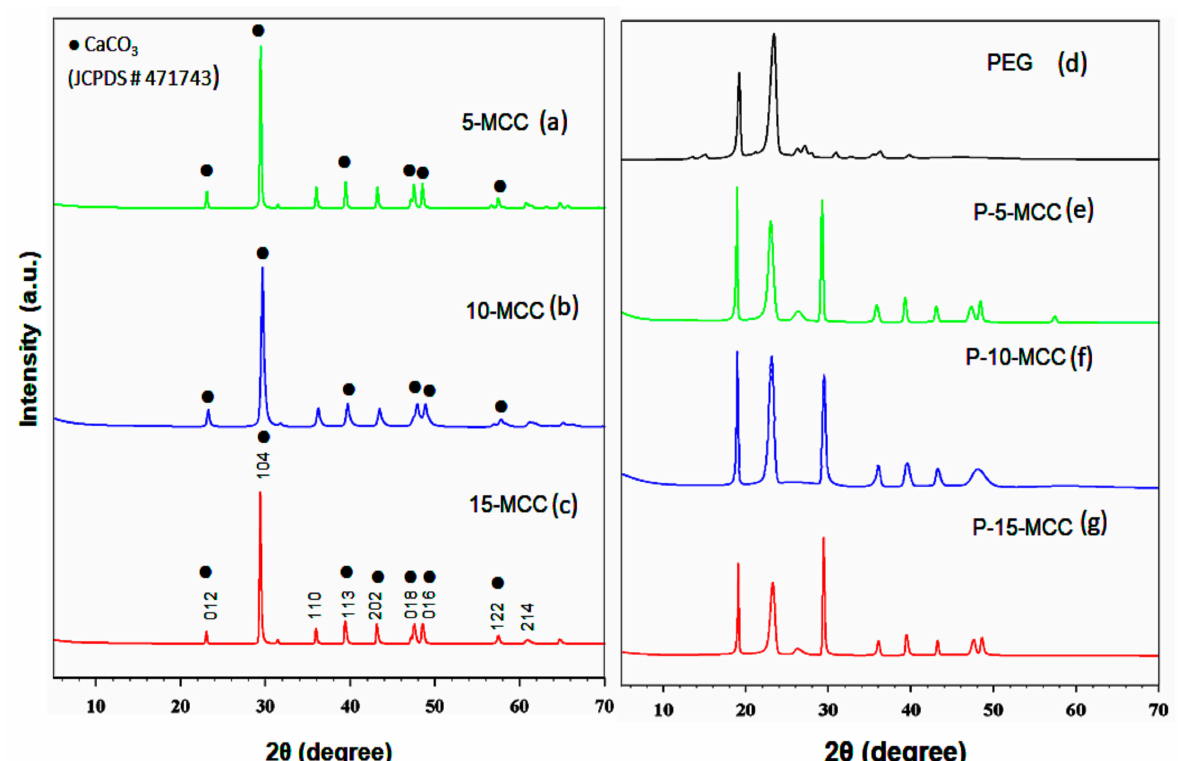
Figure 1. XRD patterns of ( a ) 5-MCC, ( b ) 10-MCC, ( c ) 15-MCC, ( d ) PEG-6000, ( e ) P-5-MCC ( f ) P-10-MCC, and ( g ) P-15-MCC